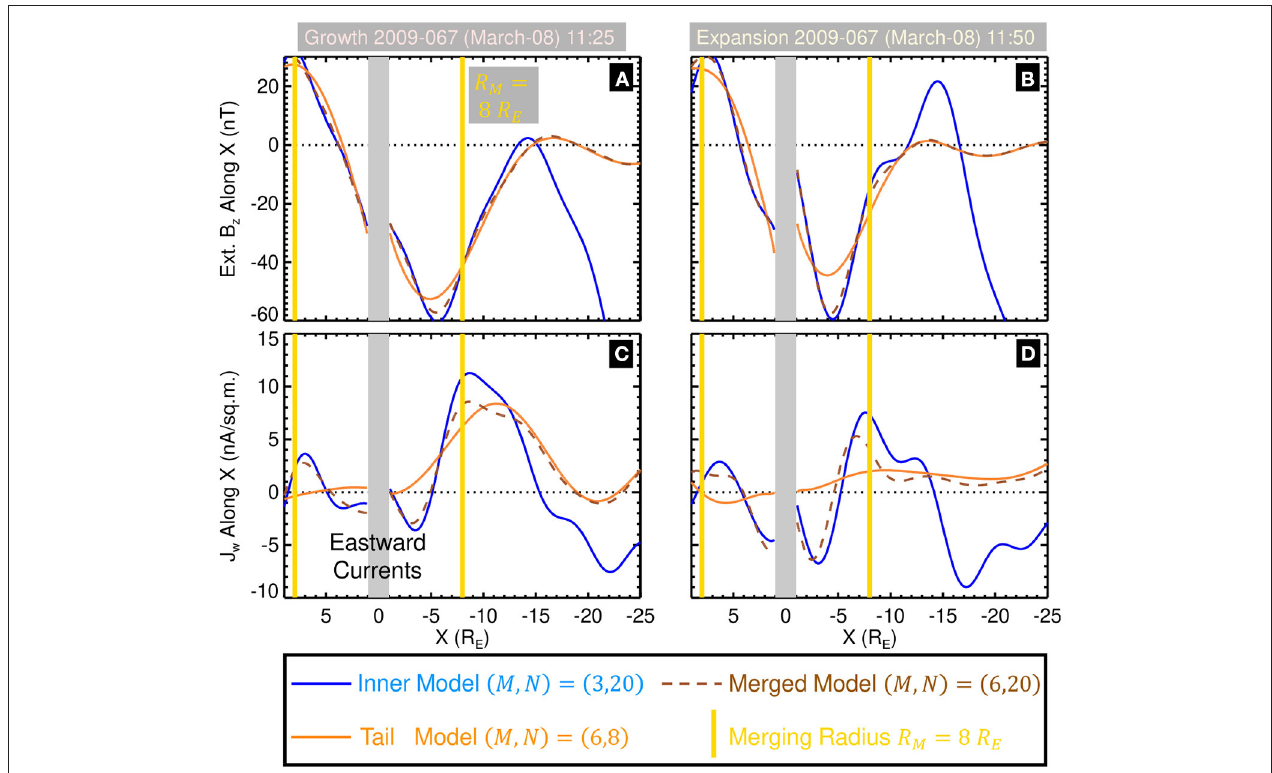
FIGURE 3 | Determination of the merging radius. Line plots of (A,B) the z -component of the external magnetic field B ext z and (C,D) the westward component of the j φ along the x axis for the Inner (blue line), Tail (orange line), and Merged (dashed brown line) for two different moments in time corresponding to current density j w = − the growth phase (left panels) and expansion phase (right panels) of the 8 March 2009 substorm. The location of the chosen merging radius R M the vertical yellow